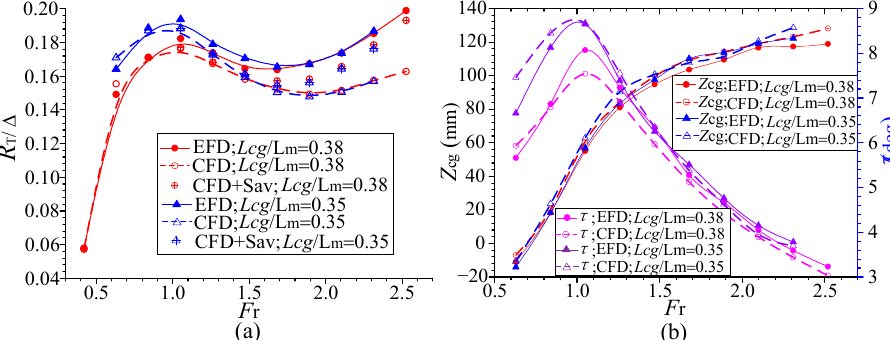
Figure 15. Comparison between EFD and CFD results for ( a ) total resistance R T and the R T added to the whisker spray resistance, ( b ) sinkage and trim angle. Table 7. The comparisons of total resistance ( R T ), sinkage ( Z cg ) , and trim angle ( τ ).